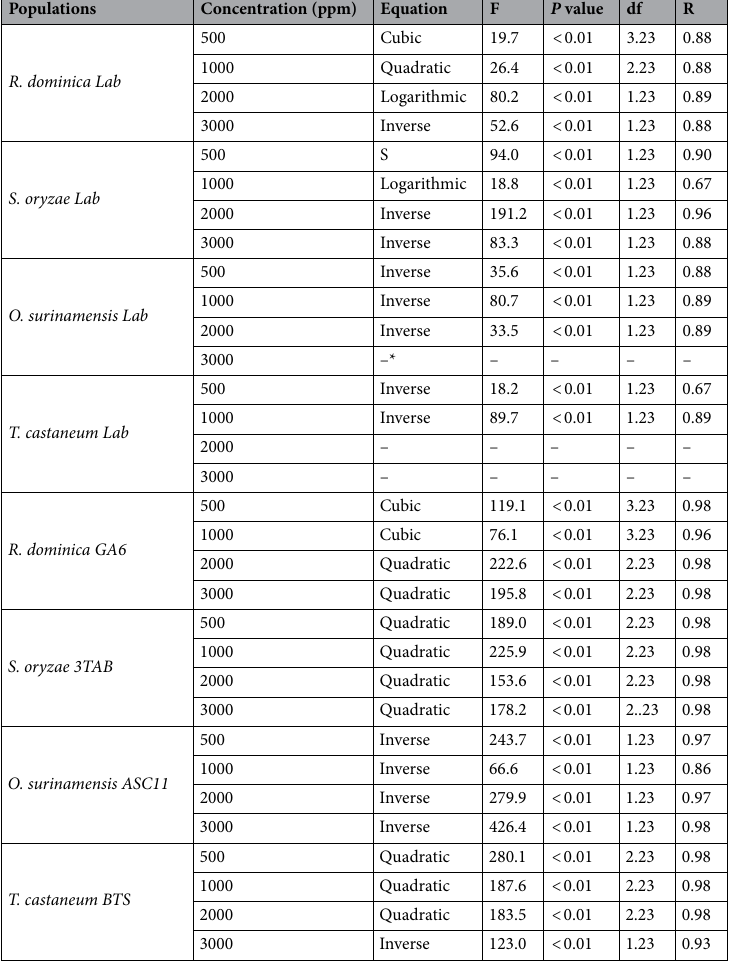
Table 6. Sweet spot curve estimations for delayed effects, of insects exposed on different concentrations (500, 1000, 2000 and 3000 ppm) throughout the different exposure intervals, for each species and population. *Equations could not be estimated.